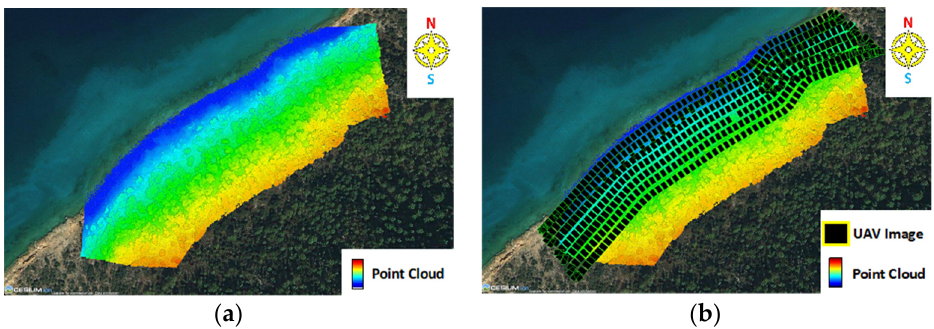
Figure 18. Illustrations of the base map and ( a ) UAV LiDAR point cloud over Dana Island overlaid with ( b ) UAV images in the Potree web-visualization portal.